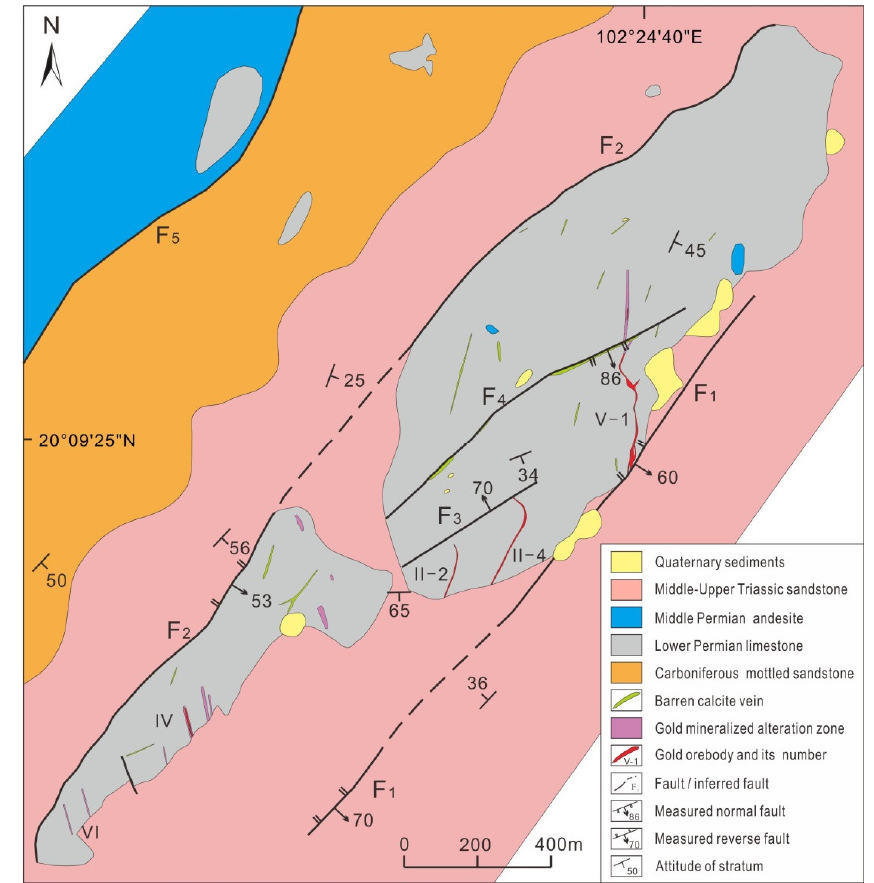
Figure 2. Sketch map of the Phapon gold deposit [13].